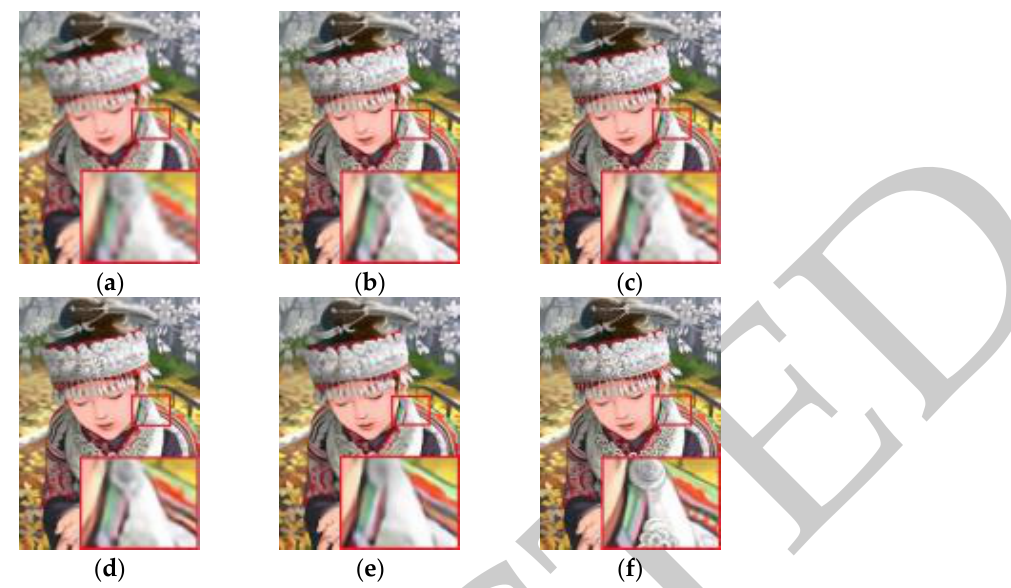
Figure 6. Super- resolution reconstruction results of the image “ Zebra ” with “ ×3 ” scale factor . ( a ) Bicubic [5]; ( b ) A+ [11]; ( c ) SRCNN [18]; ( d ) EEDS [20]; ( e ) The Proposed Method; ( f ) Original Image.